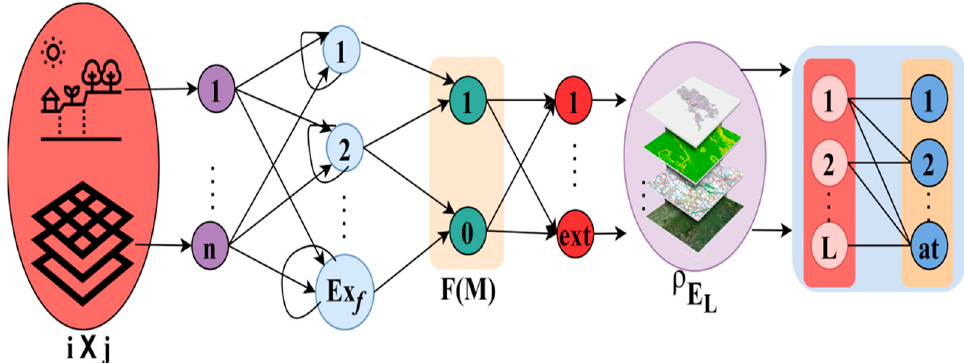
Figure 4. Learning process.